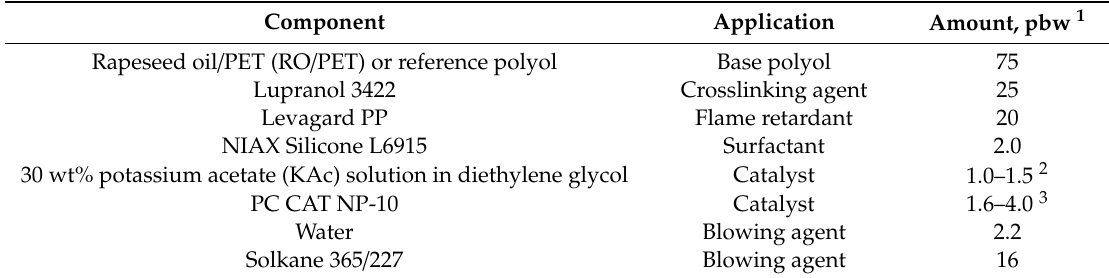
Table 1. Formulations of rigid polyurethane (PUR)